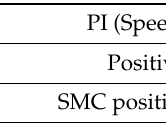
Table 2. Gains of control system.